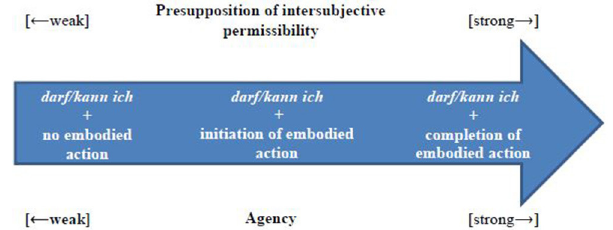
Figure 15: Continuum of presupposition of intersubjective permissibility and agency in relation to speakers’ embodied conduct during darf/kann ich?